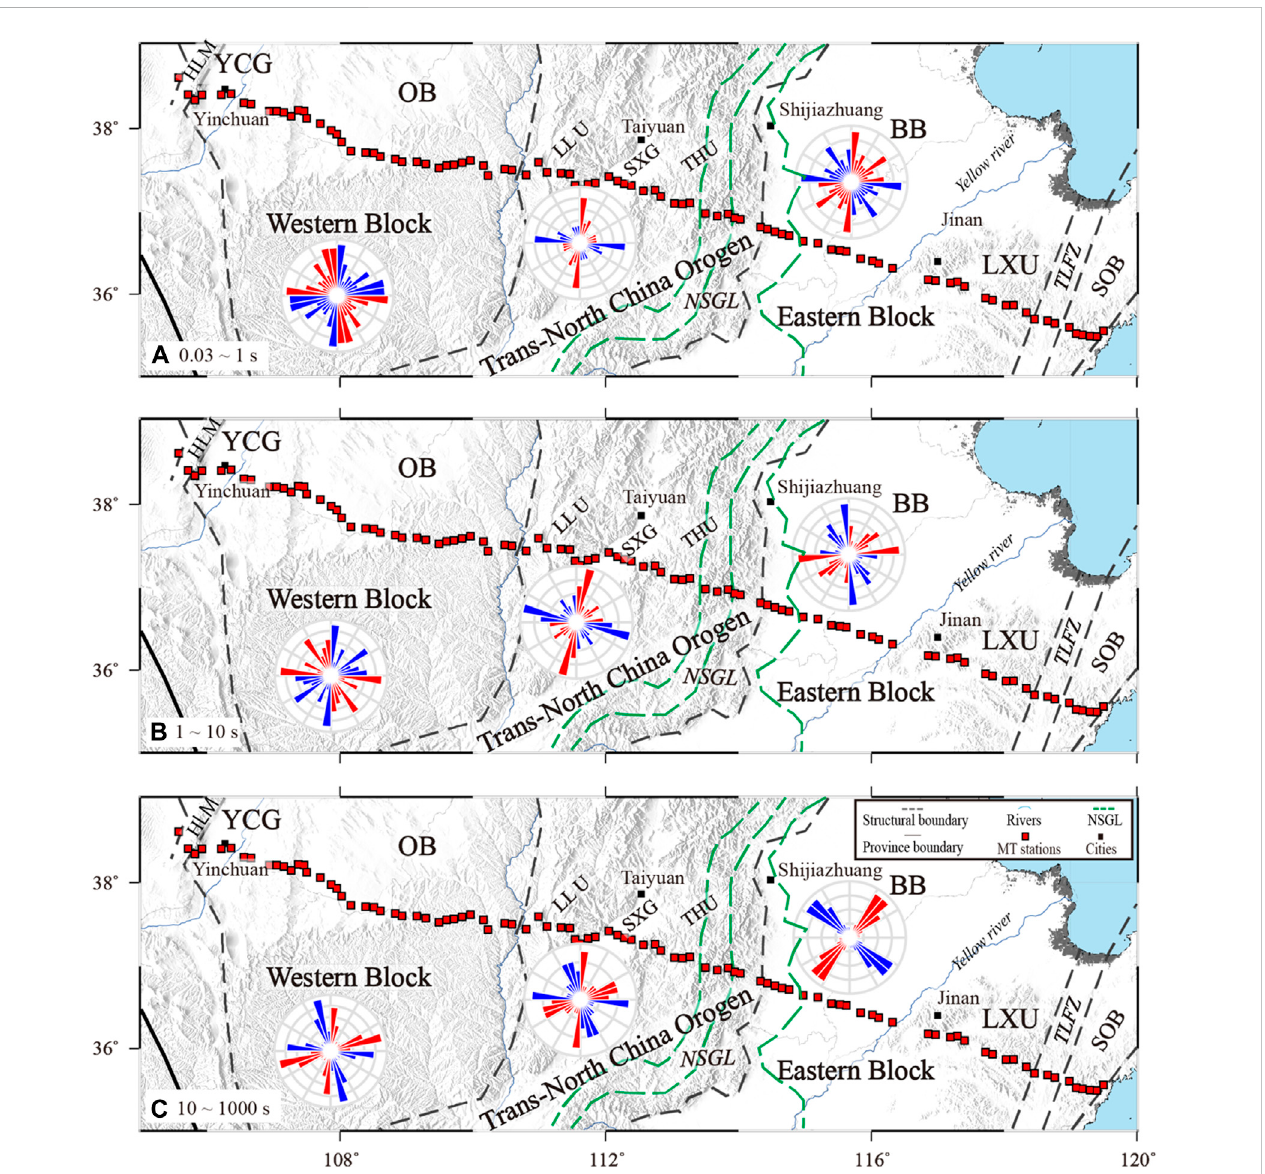
FIGURE 5 Impedancetensor decompositionresultsofthreeperiodbandsofthreegroupsofstationsintheWesternBlock,theTrans-NorthChinaOrogen,andthe Eastern Block, respectively. (A) .03 – 1 s, (B) 1 – 10 s, and (C) 10 – 1000 s. HLM: Helan Mountain, YCG: Yinchuan Graben, OB: Ordos Block, LLU: Lüliang Uplift, SXG: Shanxi Graben, THU: Taihang Uplift, BB: Bohaiwan Basin, LXU: Luxi Uplift, SOB: Sulu Orogenic Belt, TLFZ: Tan-Lu Fault Zone, and NSGL: North-South Gravity lineament after (Deng et al.,